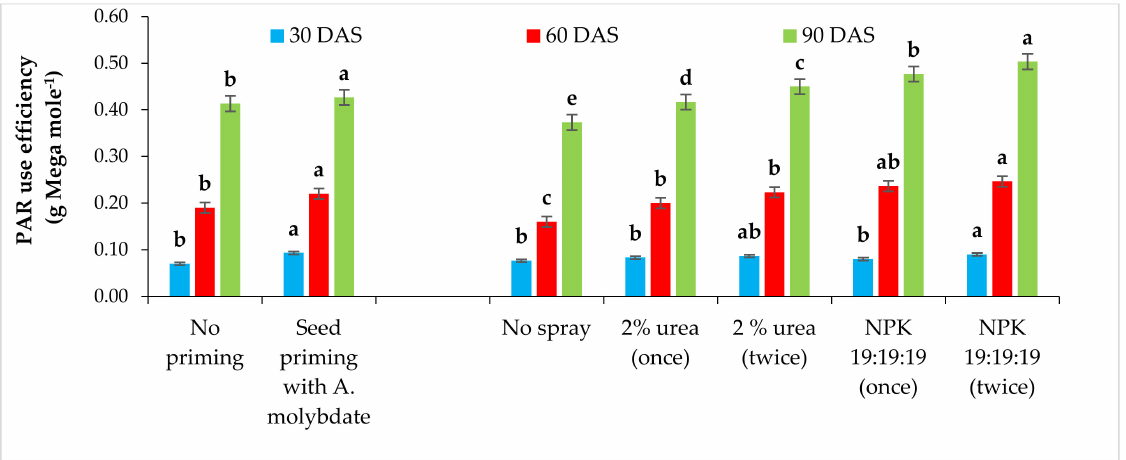
Figure 7. PAR use efficiency at different growth stages of grass pea (pooled means of 2 years). (Different letters in all bars indicate significant differences between